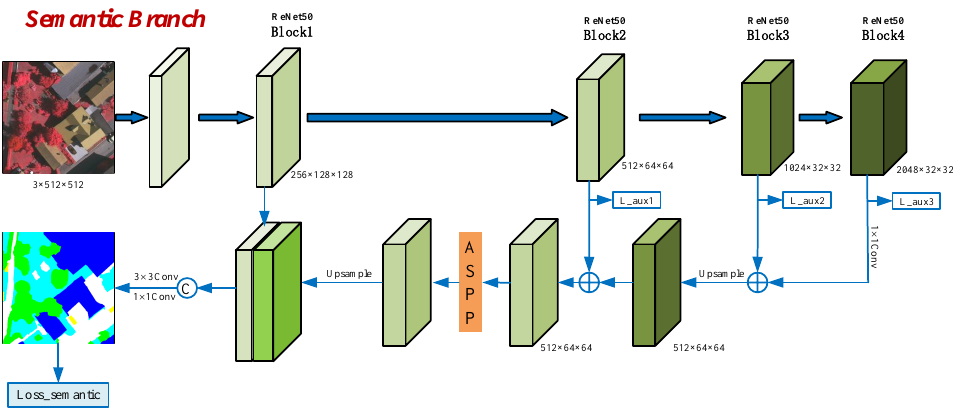
Figure 2. The framework of the semantic